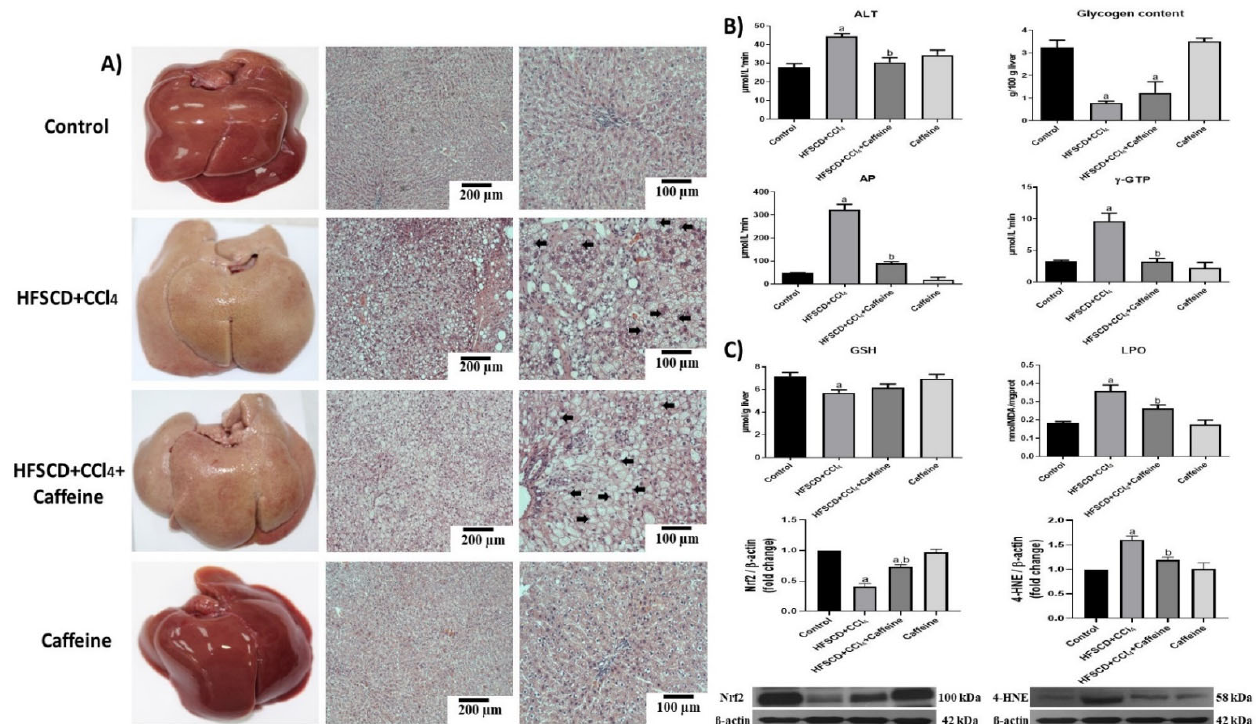
Figure 1. Effect of caffeine on the liver structure, liver damage, and oxidative stress markers in rats fed a high ‐ fat, ‐ sucrose, and ‐ cholesterol diet plus CCl 4 (HFSCD+CCl 4 protocol or NASH model). ( A ) Macroscopic anatomy and microscopic liver structure. H&E staining of hepatic tissues from rats in the control, HFSCD+CCl 4 , HFSCD+CCl 4 +caffeine, and caffeine groups. Scale bar = 200 and 100 μ m. Arrows show nuclei displaced toward the periphery of the cells. ( B ) Markers of liver damage. Serum alanine aminotransferase (ALT), gamma ‐ glutamyl transpeptidase ( γ‐ GTP), alkaline phosphatase (AP) activities, and hepatic glycogen content. Bars represent the mean of experiments performed in duplicate ± SEM (n = 8). ( C ) Oxidative stress markers. Degree of lipid peroxidation (LPO) and content of reduced glutathione (GSH). Bars represent the mean of experiments performed in duplicate ± SEM (n = 8). Western blot of 4 ‐ hydroxynonenal (4 ‐ HNE) and nuclear factor ‐ E2 ‐ related factor 2 (Nrf2) proteins. Bars represent the mean of experiments performed in duplicate ± SEM (n = 3): β‐ actin was used as a loading control. (a) p < 0.05 compared with the control group; (b) p < 0.05 compared with the HFSCD+CCl 4 group.